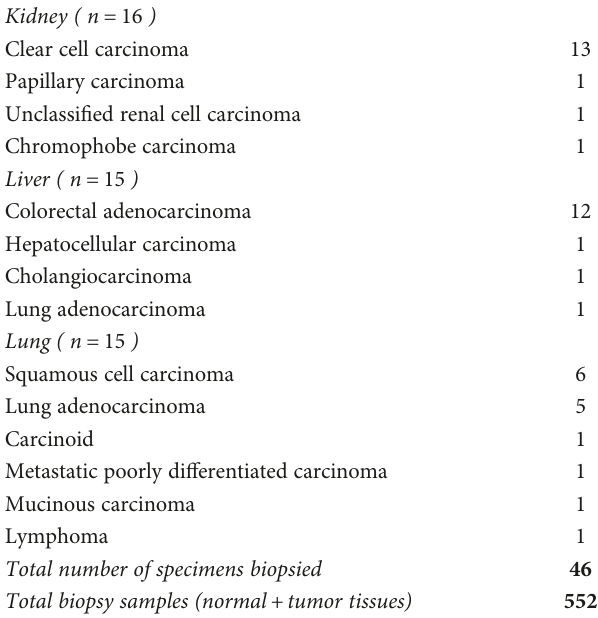
Table 1: Pathologic tissue diagnoses by